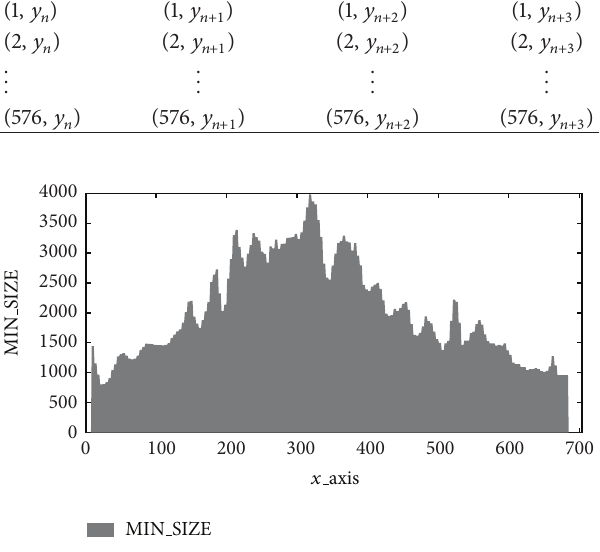
Figure 14: A new MIN SIZE threshold